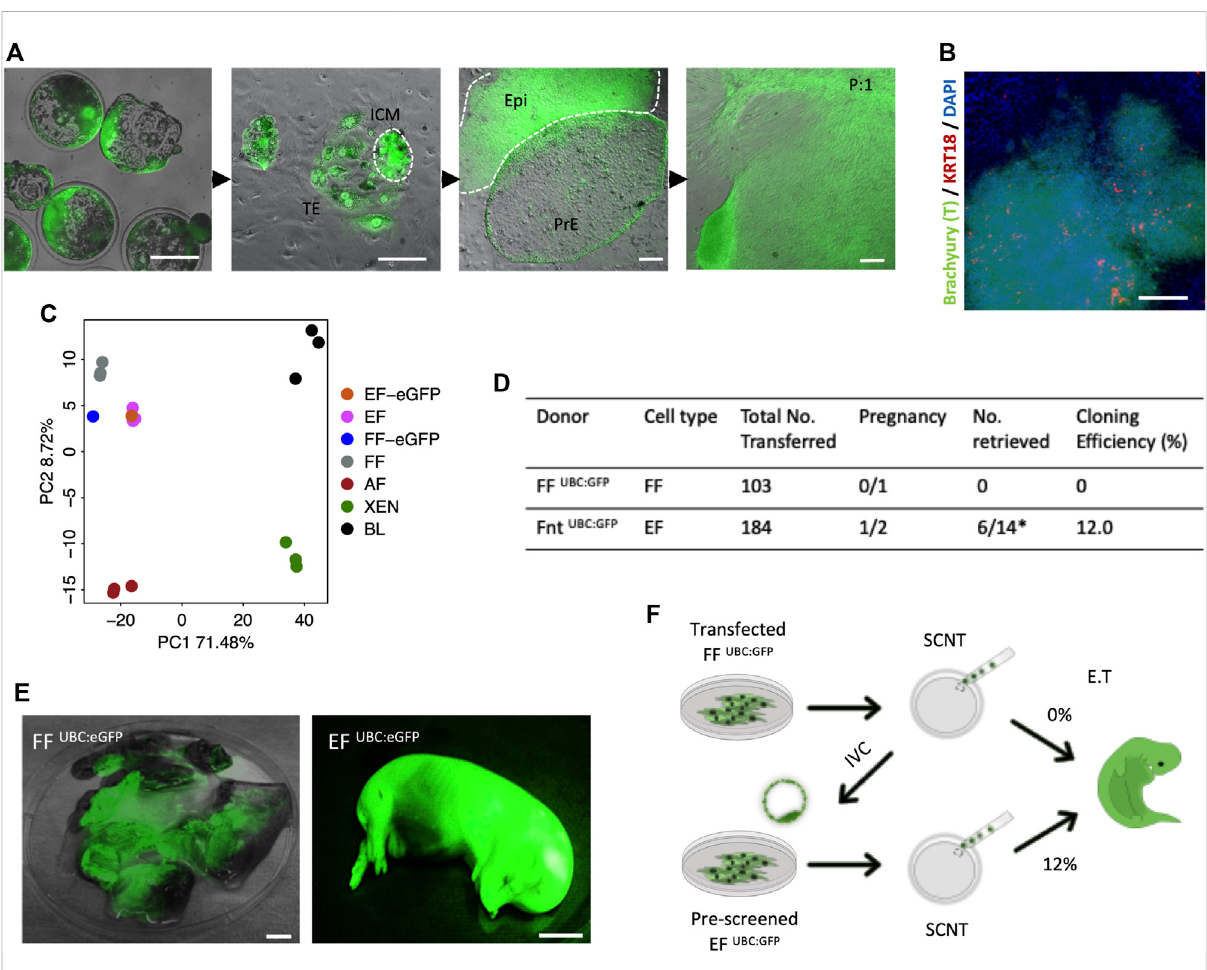
FIGURE 3 Invivo developmentof40-dayfetusesfollowingSCNT. (A) RepresentativeimagesoftheblastocystoutgrowthsandthederivationofEFandPRE cells. The constitutive hUBC promoter-driven GFP transgenic FF (FF UBC:eGFP ) were used for generating SCNT. The establishment of primary outgrowths from SCNT embryonic explants on day 2 of culture and the emergence of PrE and Epi in d9 primary outgrowths. After the fi rst passage, fi broblast-like cells grew from the differentiated cell clump (EF UBC:eGFP ). (B) Immuno fl uorescence staining con fi rmed that thedifferentiated cell clusters were Brachyury positive but KRT18 negative after 15 days of differentiation in the IFM medium. (C) PCA plot of FF UBC:eGFP and EF UBC:eGFP . (D) Pregnancy and cloning ef fi ciency rate of pig embryos generated from FF UBC:eGFP and EF UBC:eGFP both on the same genetic background. (E) Representative images of mummi fi ed fetuses from FF UBC:eGFP (left) and normal developmentally competent fetuses from EF UBC:eGFP cloned embryos (right)expressingubiquitous eGFPonday40ofpregnancy. (F) Schematicsummaryofthegenome-edited experimentshighlightingimprovedSCNT ef fi ciencies with the use of EF as nuclear donor cells in SCNT. Bar, 1